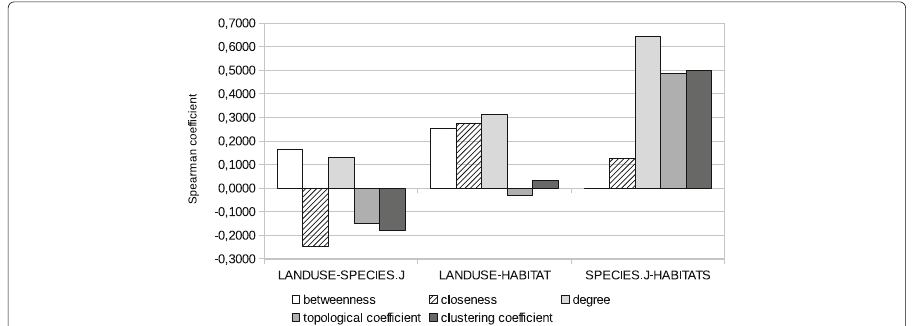
Fig. 5 Histogram representation of Spearman correlation of various complex network indices, between pairs of similarity-based graphs. Species-set graphs built using Jaccard coefficients, land-use and habitats graphs built using cosine similarity of